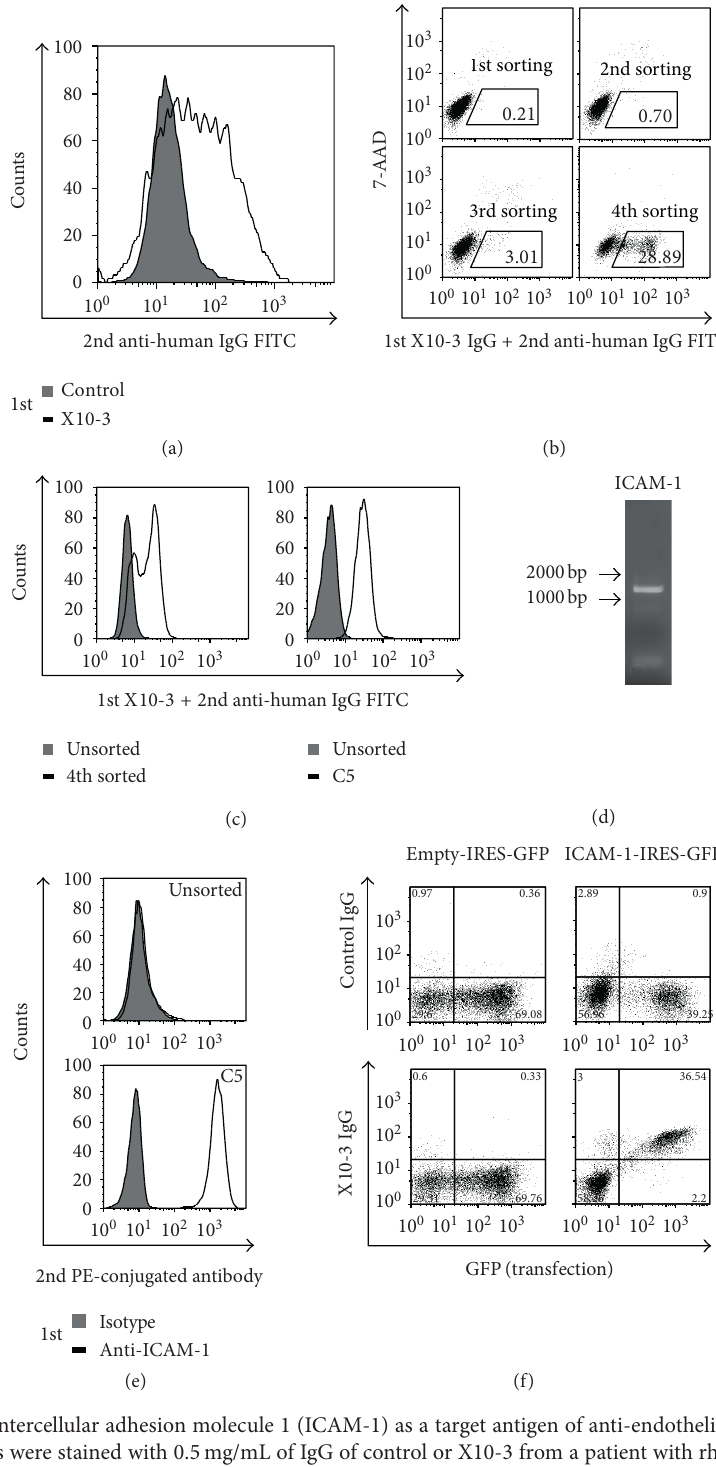
F 2: Identi�cation of intercellular adhesion molecule 1 (ICAM-1) as a target antigen of anti-endothelial cell antibodies (AECAs). (a) Nonpermeabilized HUVECs were stained with 0.5mg/mL of IgG of control or X10-3 from a patient with rheumatoid arthritis followed